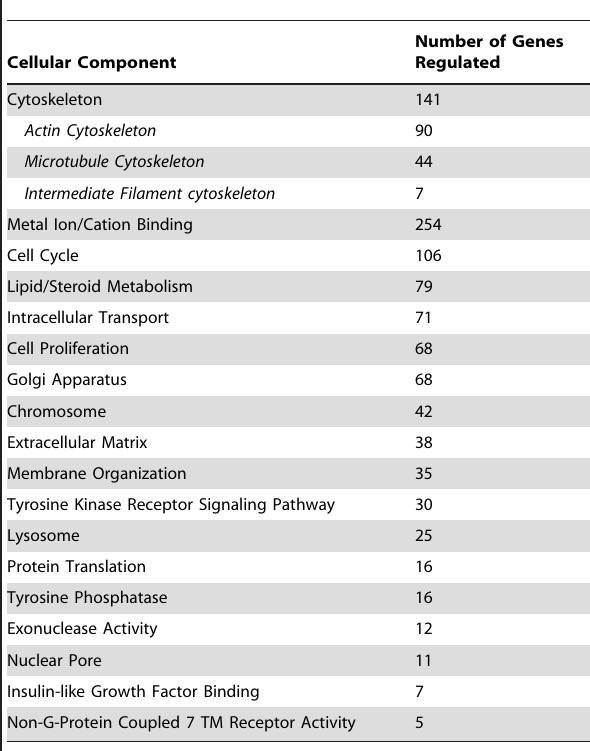
Table 1. Over Represented Gene Ontology Categories by Differentially Expressed Genes in MOSE Cell Stages Late vs.